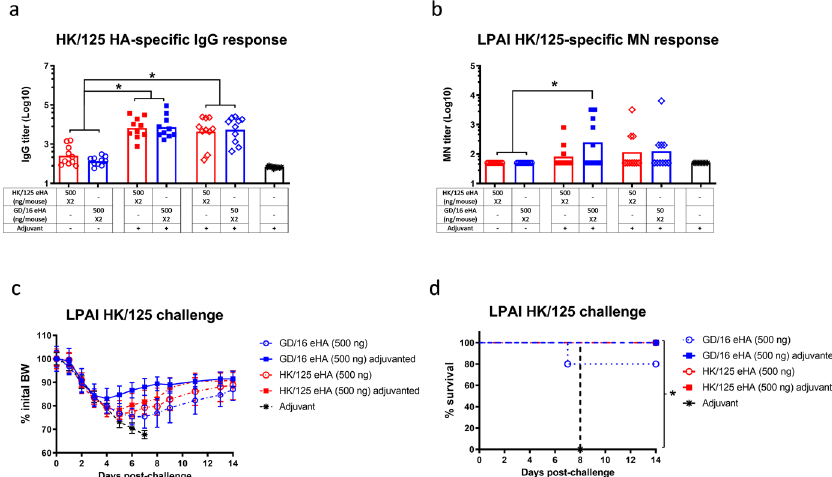
Fig. 2 Immunogenicity and protection against Low pathogenic avian in fl uenza H7N9 virus of the fi fth wave. BALB/c mice were immunized twice with HA extracted (eHA) from H7N9 candidate vaccine viruses A/Hong Kong/125/2017 (HK/125) or A/Guangdong/17SF003/ 2016 (GD/16) with or without adjuvant. Immunized mice were challenged with low pathogenic avian in fl uenza (LPAI) wild type (wt) H7N9 HK/ 125 virus in a BSL-3 + biocontainment. ( a ) IgG ELISA titers against HK/125 HA; ( b ) microneutralization (MN) titers against LPAI wt HK/125 virus; ( c ) body weight (BW) and ( d ) survival after LPAI wt HK/125 challenge. Individual titers with geometric mean (bars) are shown ( n = 5 – 10 mice/ group). BW data are expressed as mean ± s.e.m ( n = 5 mice/group). * p < 0.05 by Kruskal – Wallis test with Dunn ’ s multiple comparisons after log transformation (antibody responses) or by Log-rank (Mantel – Cox) test (survival curves).